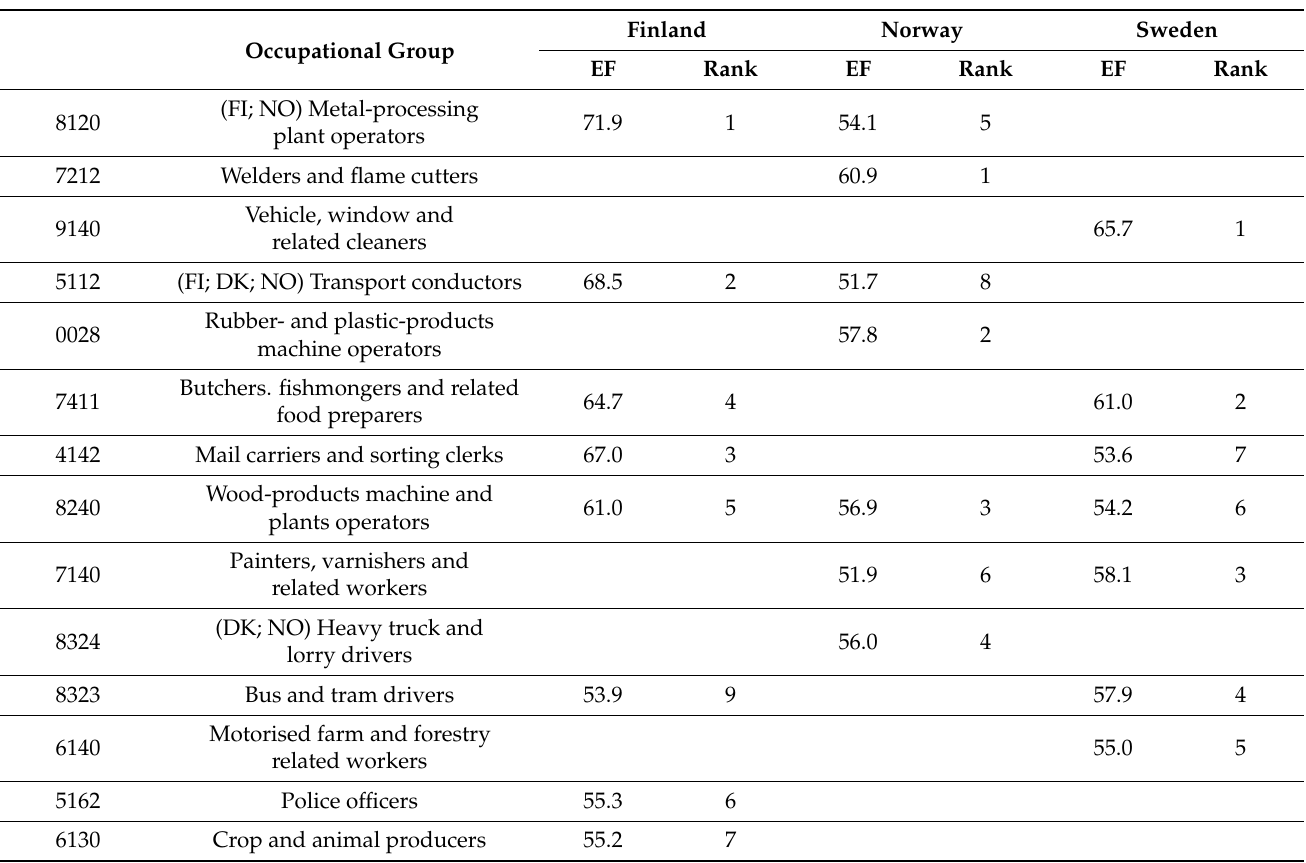
Table 5. Occupational groups with rank 1–10 based on the excess fraction (EF, %) of the